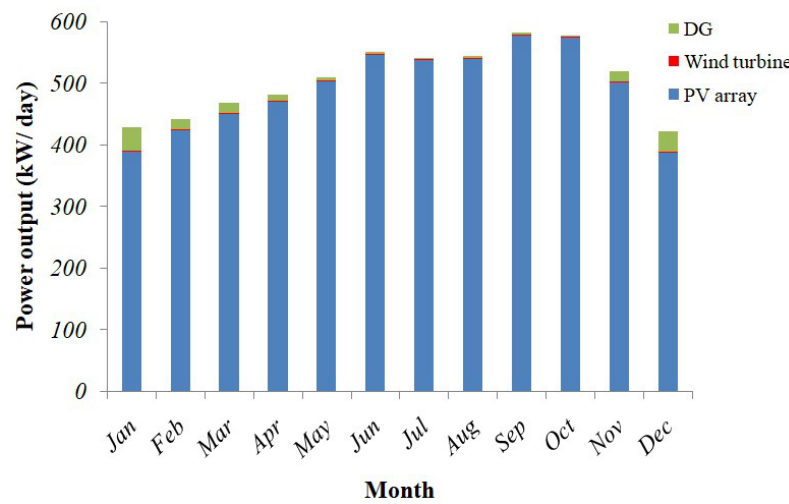
Figure 17. Monthly electricity production of PV-Wind-BSS-DG configuration.